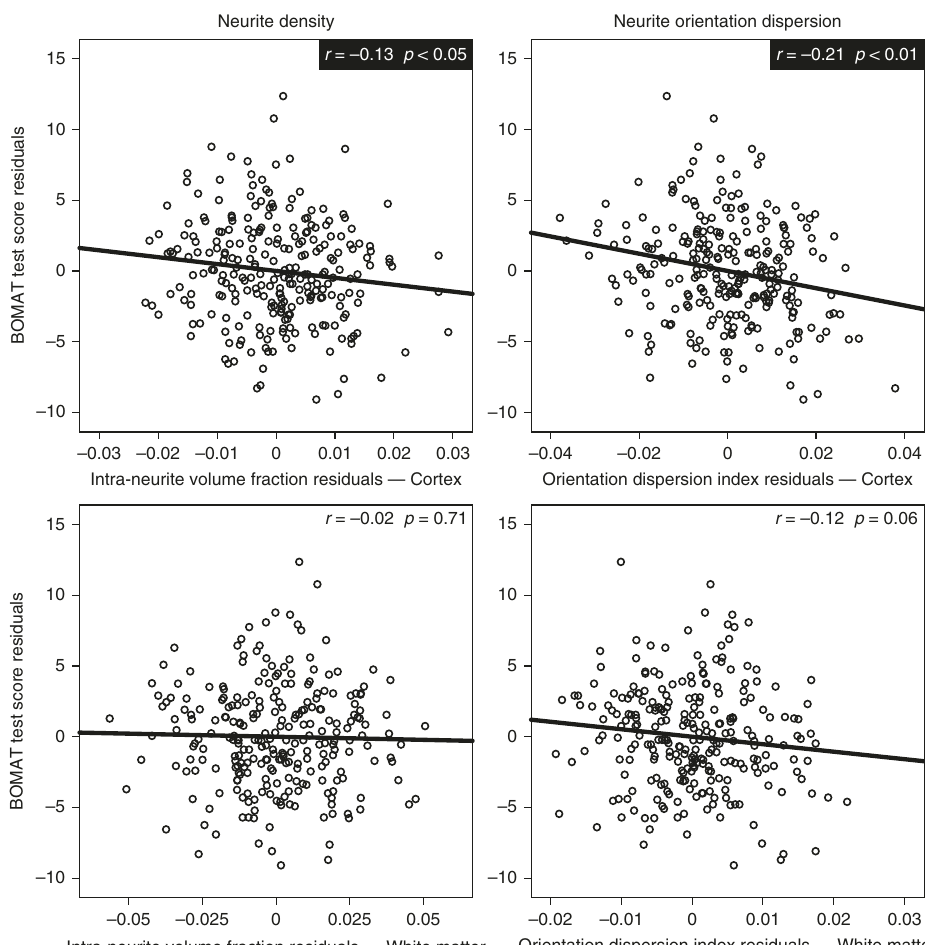
Fig. 2 Partial correlation analyses with data from sample S259 quantifying structure – function associations at the whole-brain level. Scatter plots illustrating the relationship between neurite density and intelligence are depicted in the left column. Scatter plots illustrating the relationship between neurite orientation dispersion and intelligence are depicted in the right column. In all cases, microstructural measures were computed as mean values derived from the overall cortex (upper row) or white matter (lower row), respectively. Results are based on partial correlation analyses with age and sex being used as controlling variables. Statistically signi fi cant partial correlation coef fi cients ( N = 259, p < 0.05) are highlighted with black